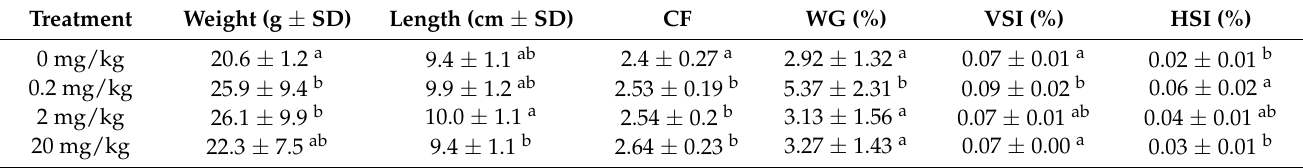
Table 1. Growth performance of fish fed test diets for 71 days.